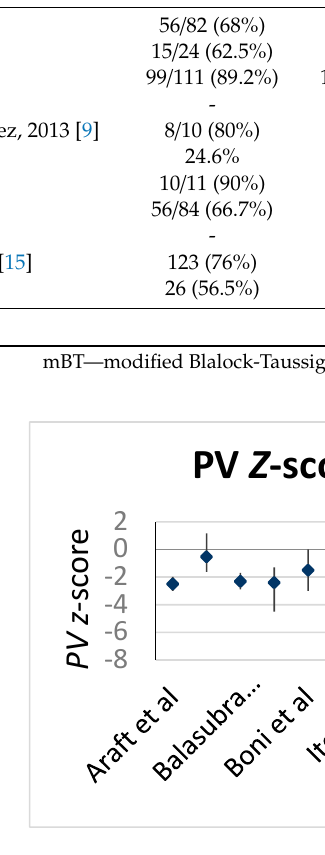
Table 2. Pulmonary valve morphology and number of shunts.